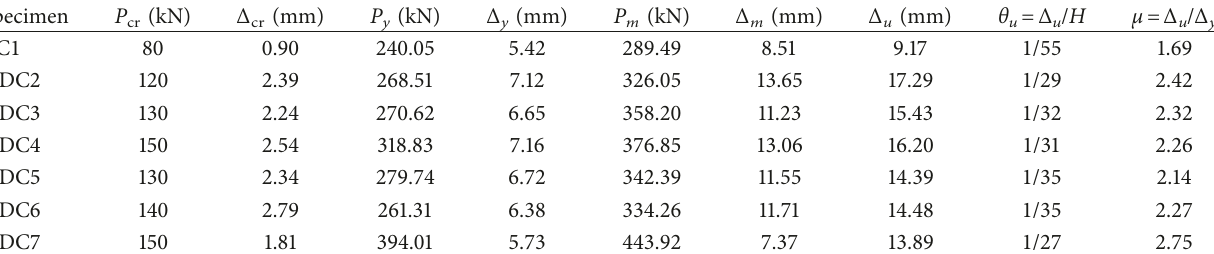
Figure 9: Skeleton curves of specimens: (a) effect of the material, (b) effect of the axial load ratio, (c) effect of the stirrup ratio, and (d) effect of the shear span ratio. Table 5: Comparisons of the characteristic load and